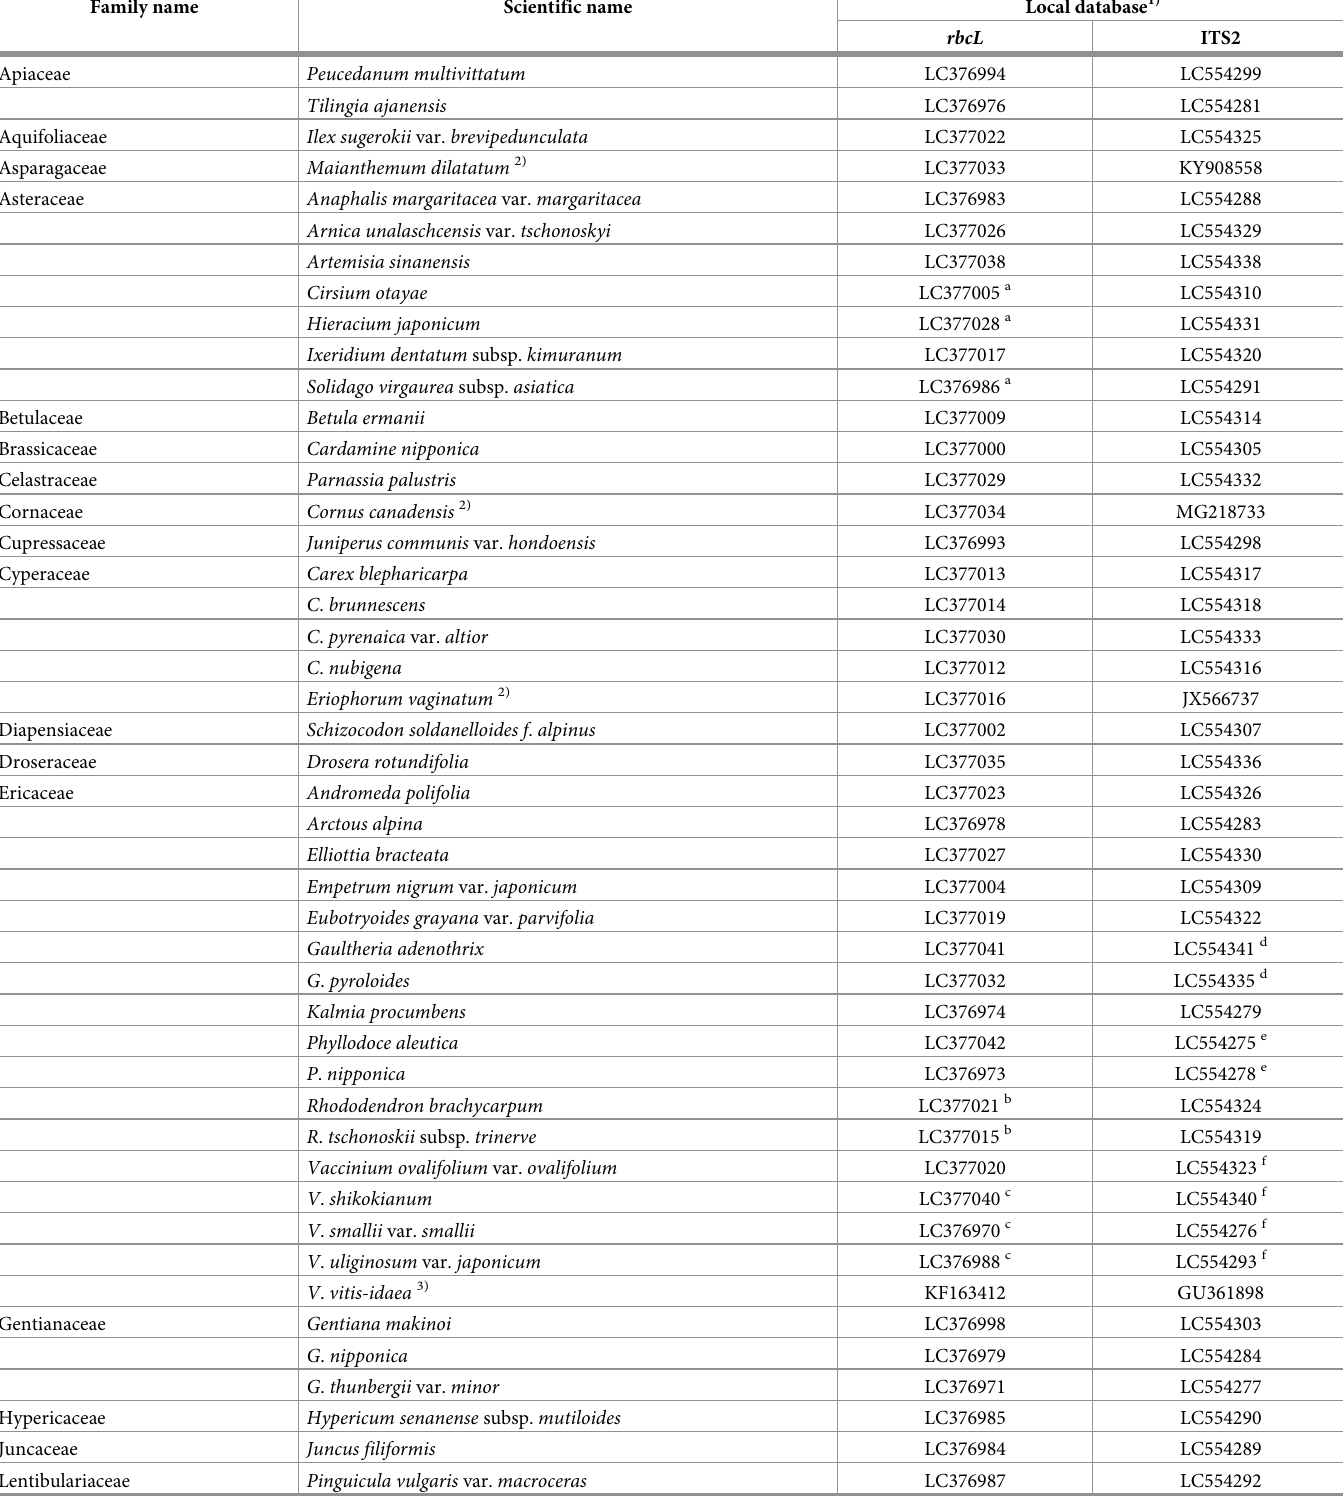
Table 2. Local databases constructed from alpine plants in the study area. Family